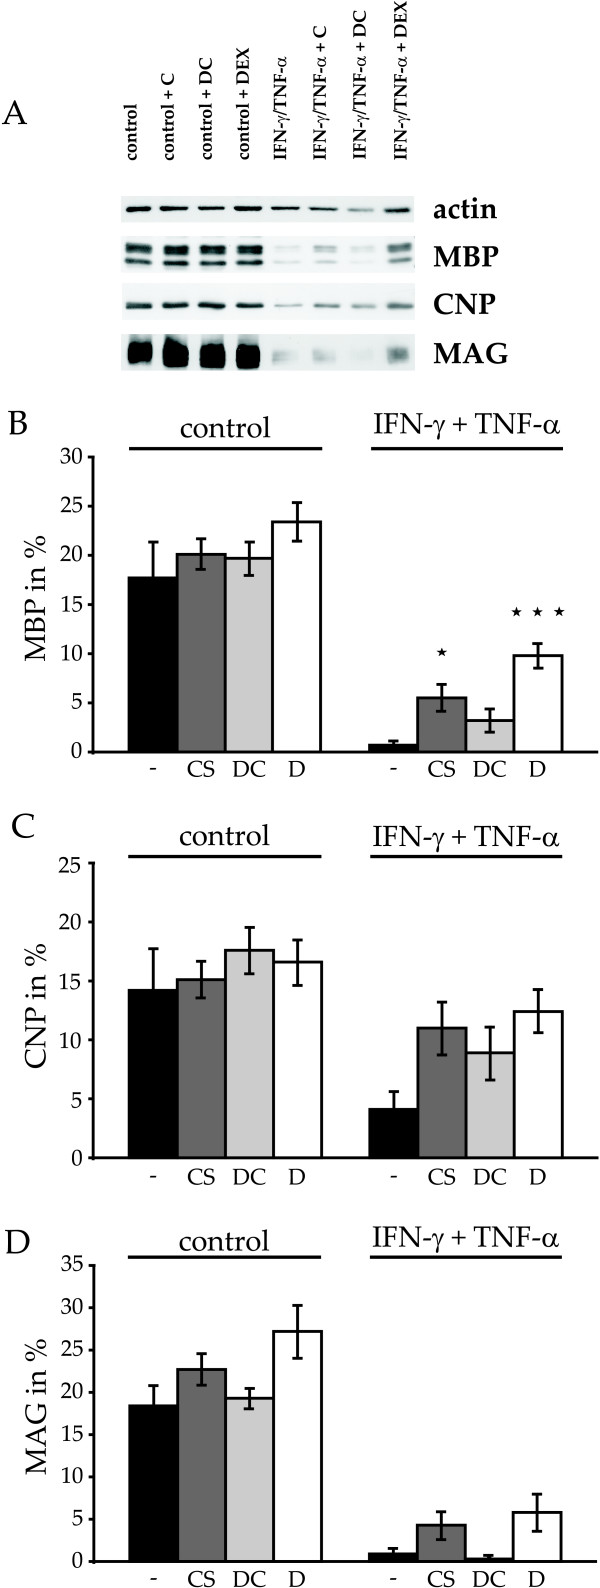
Protein expression of MAG, MBP and CNP at culture day 9. Note the strong reductions of myelin protein expression normalized to actin in western-blots from cells preincubated with IFN-γ and TNF-α (bars to the right). Cotreatment with corticosterone (CS), deoxycorticosterone (DC) or dexamethasone (D), significantly attenuated the inhibition of protein expression for MBP (B) and showed a non-significant tendency for a recovery of CNP (C) and MAG (D), *p < 0.05, ***p < 0.001. For reasons of comparison data shown in (B) are based on the same dataset as those shown in Figure 2A of [31].